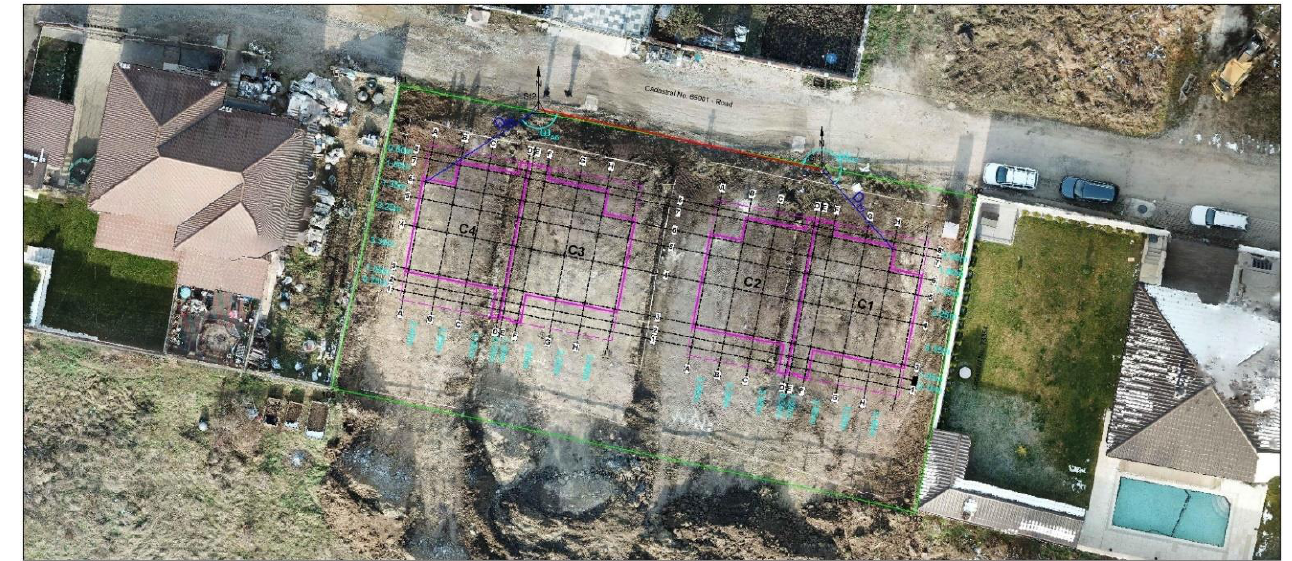
Figure 8. Layout site with an unmanned aerial vehicle (UAV) orthophoto layer.